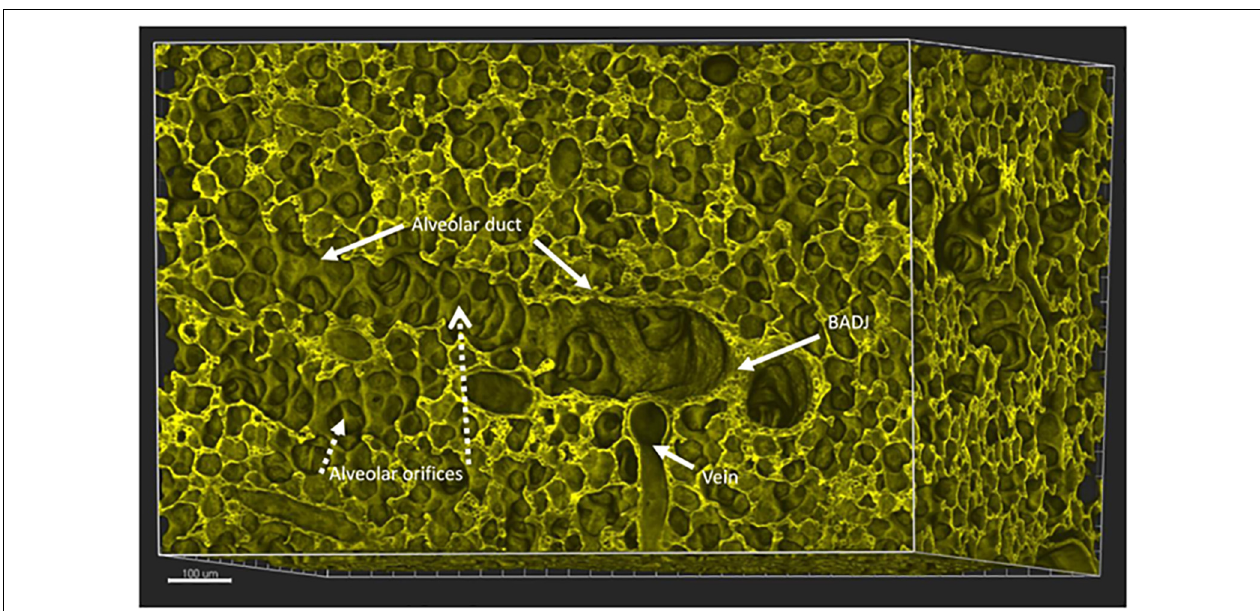
FIGURE 2 | Mouse lung aged 14 days postnatal, a time by which alveolarization has substantially progressed in mice. A digital 3D reconstruction of a whole mouse lung imaged by Vibra-SSIM technology. Membrane fluorescence is imparted by the tomato transgene. This stereo-optical view shows a broncho-alveolar duct junction (marked as BADJ), viewed en face and identified by the sharp columnar to flattened epithelial transition. Two alveolar ducts are viewed proceeding distally to this BADJ structure, one posteriorly and interiorly while a second duct (marked as Alveolar duct) proceeds toward the left from the BADJ. Many individual alveolar orifices (marked as Alveolar orifices) are seen arising from the lateral surface of this alveolar duct. In this 3-dimensional view the mouth or orifice of each alveolus or air sac is surrounded by a round purse string like structure that circumscribes the entrance to each alveolus. Some of the purse strings can also be viewed in oblique cross section, where they appear as the tips of finger-like structures, previously delineated in the literature as “alveolar septae.” A pulmonary vein is also viewed in 3D. Alveolar capillaries can also be discerned in cross section between alveolar surfaces. Scale bar 100